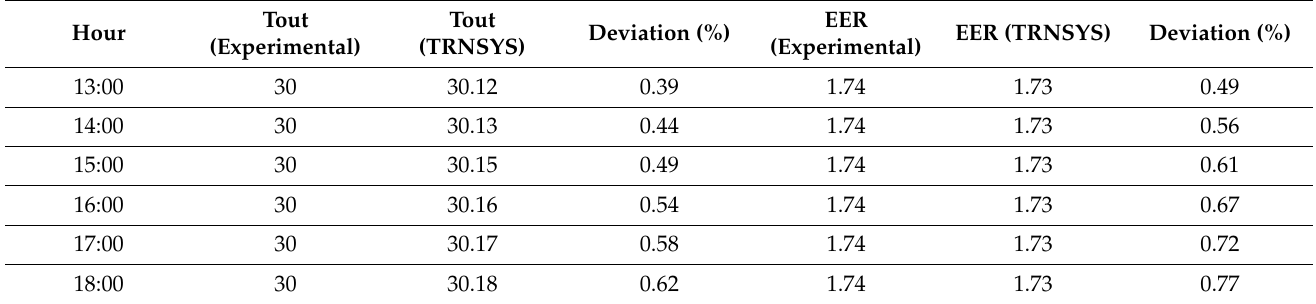
Table 5. Results and deviation of the performance of the simulation and experimental data at 3 GPM.